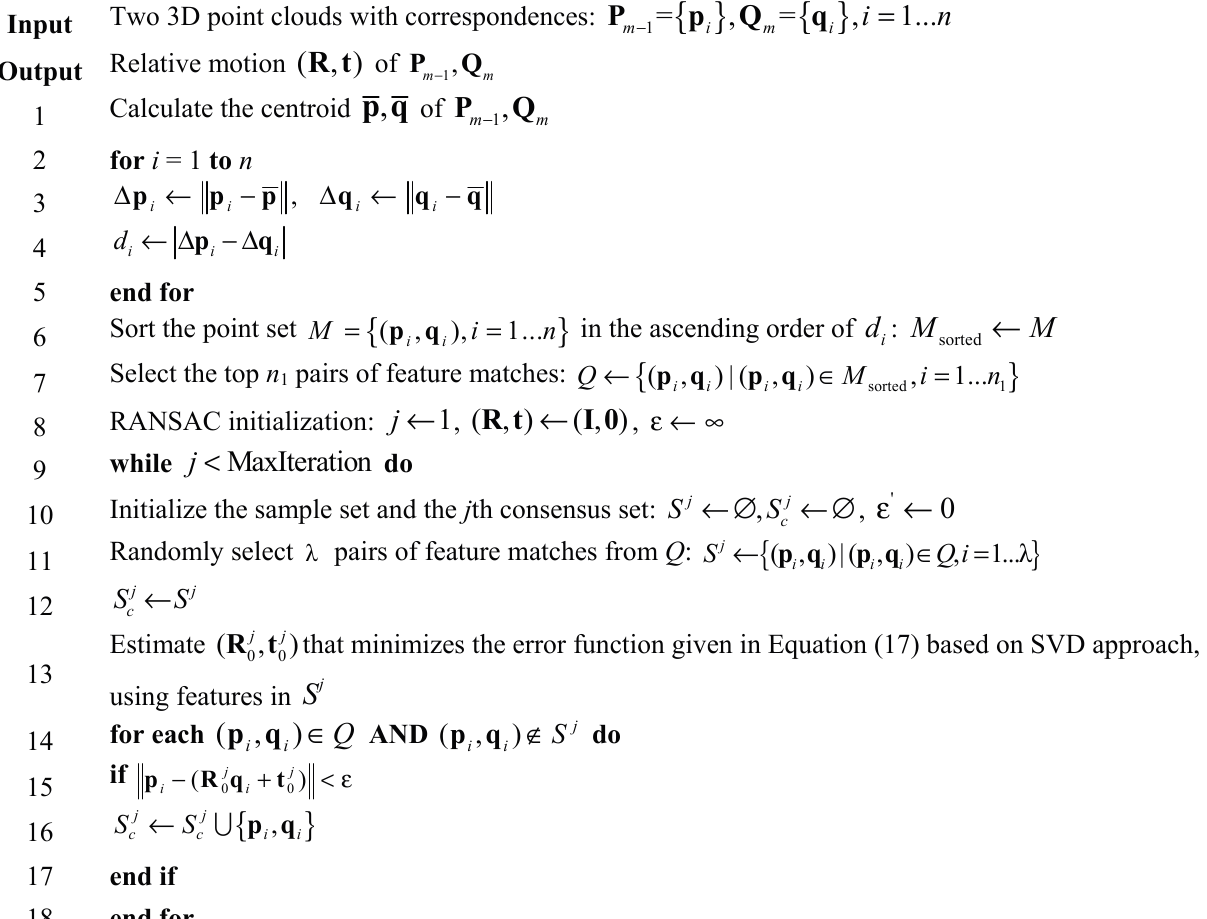
Algorithm 2. Consistency-RANSAC inlier detection and relative motion estimation.